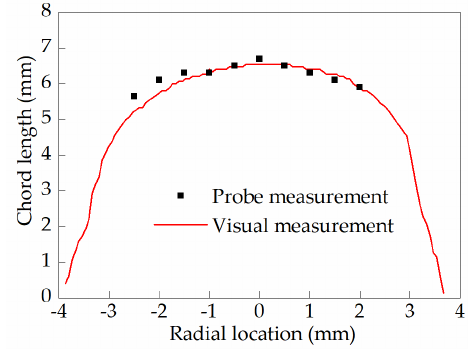
Figure 13. Bubble chord length from probe and visual measurement.